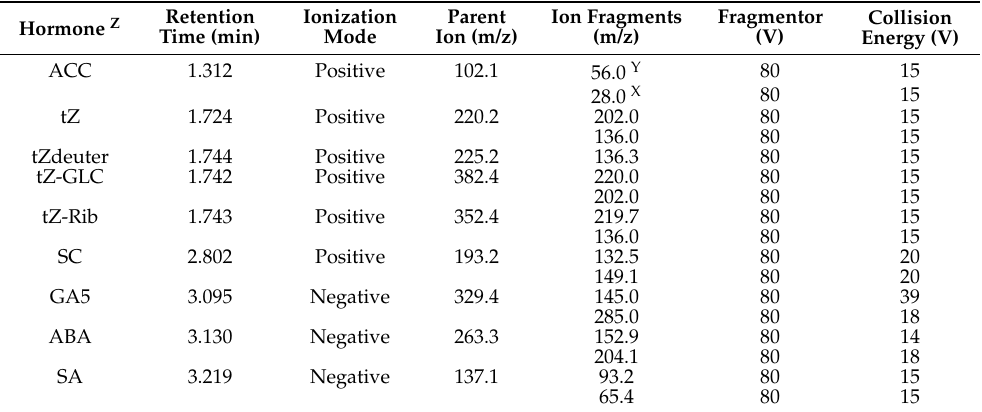
Table 2. Ultra-high-performance liquid chromatography (UHPLC) coupled triple quadrupole mass spectrometry (UHPLC-QqQ-MS/MS) parameters for the identification, identity confirmation (second MRM transition) and quantification of the